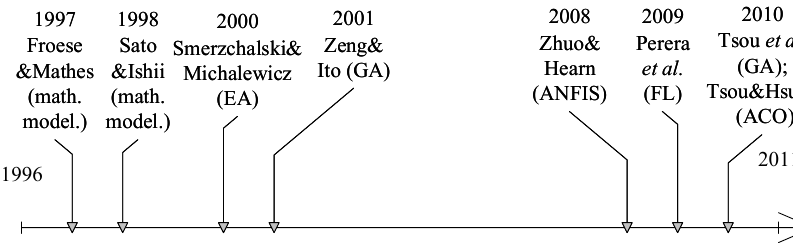
25 analyzed methods, 32% used or assumed the usage of a radar system as a source of TSs data, another 32%-of both radar and AIS. In total, 16% of analyzed approaches declared or applied a radar system and other sensors, such as cameras, and 20% used only AIS. A chart presenting these statistics is given in Figure 9.